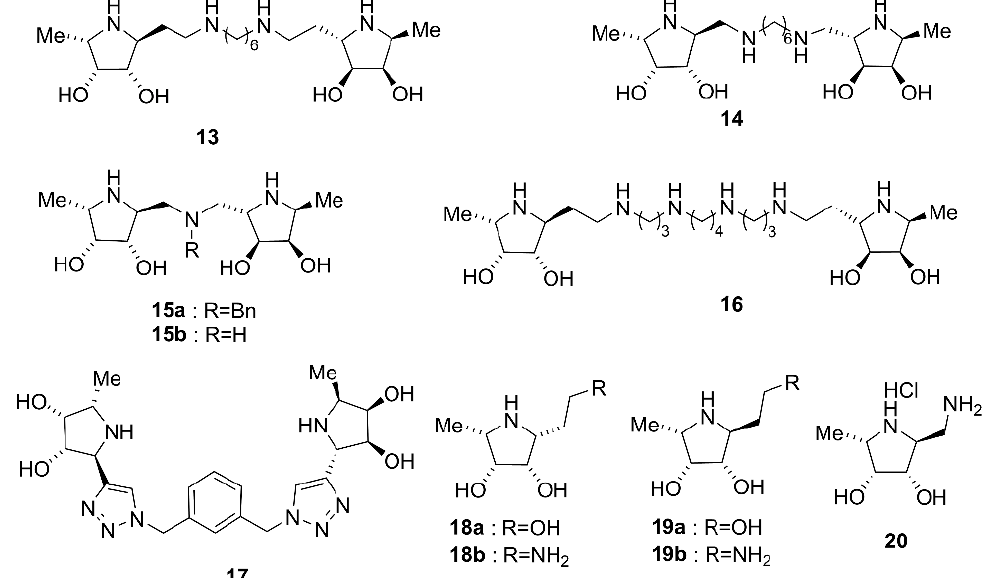
Figure 4 . Structures of divalent iminosugars 13 – 17 and monovalent references 18 – 20 . Figure 4. Structures of divalent iminosugars 13 – 17 and monovalent references 18 – 20